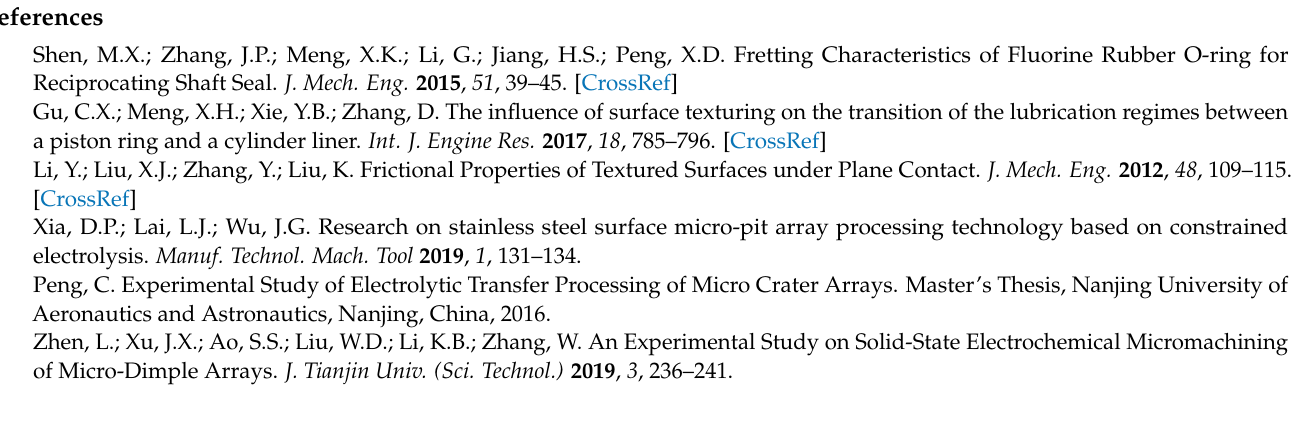
Figure 15. Action mechanism of coupling